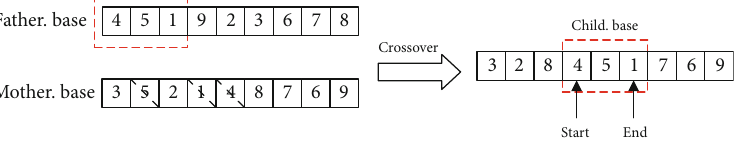
Figure 4: Crossover